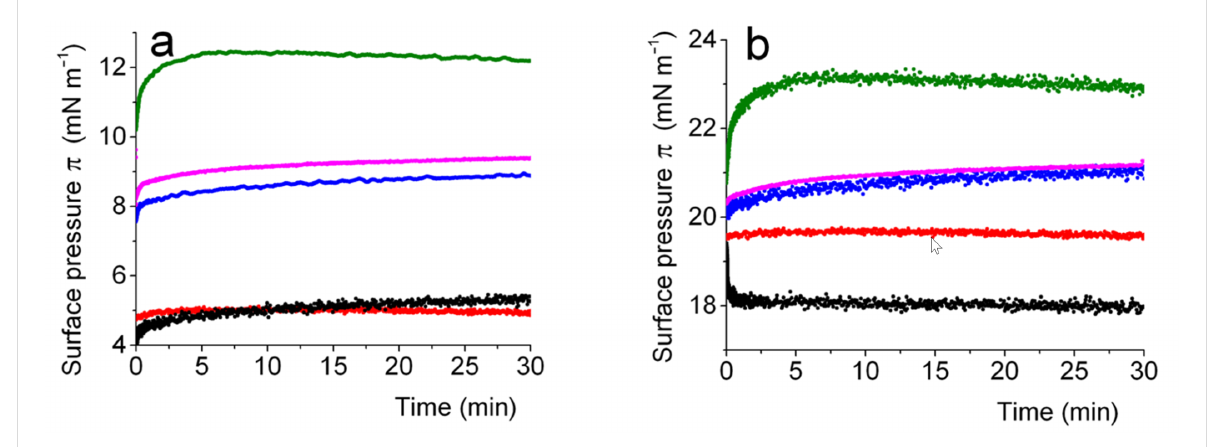
Figure 2: Adsorption of perfluoroalkylated lipopeptides 1 – 3 and hydrocarbon analog 4 on DPPC monolayers spread at the air/water interface a) in the liquid expanded (LE) and b) in the liquid condensed (LC) phases (25 °C). Variation of the surface pressure π as a function of time for a DPPC mono- layer (red), and after injection of the lipopeptides in the aqueous sub-phase of a DPPC monolayer for F -lipopeptides: 1 (blue), 2 (magenta), 3 (green), and hydrocarbon analog 4